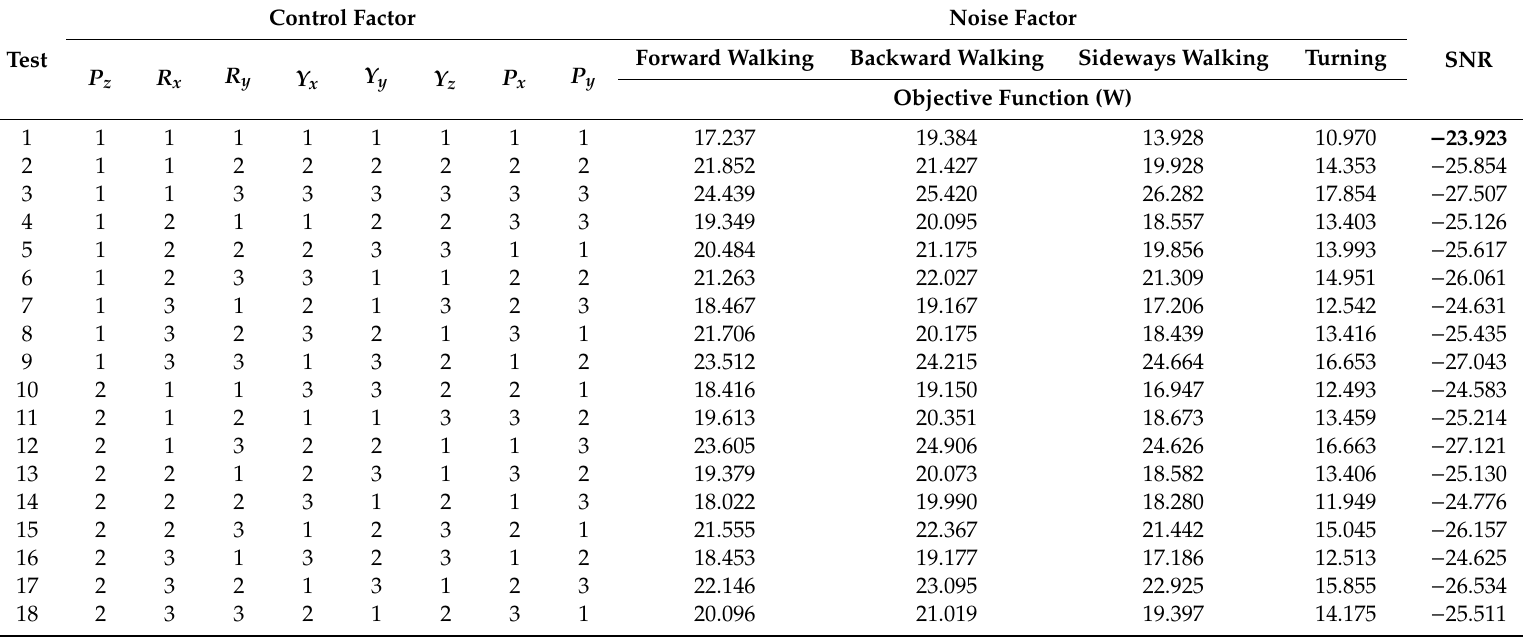
Table 2. Design, results, and SNRs of first experimental set. (The highest SNR is